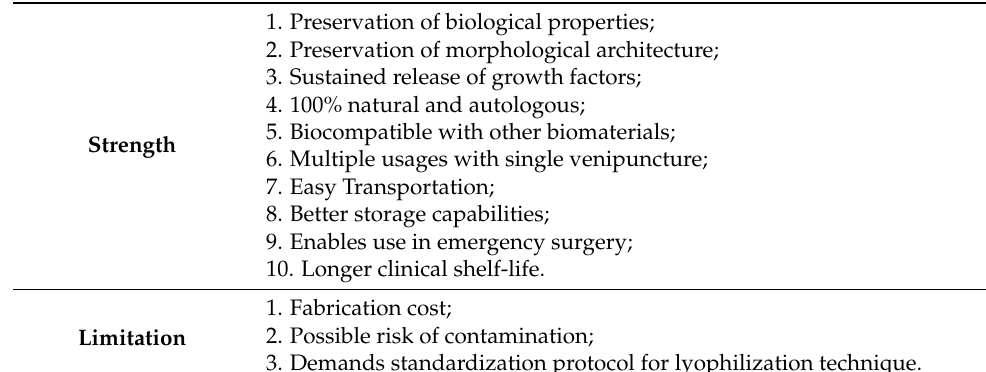
Table 3. Strengths and limitations of the lyophilized platelet concentrate (LPC)